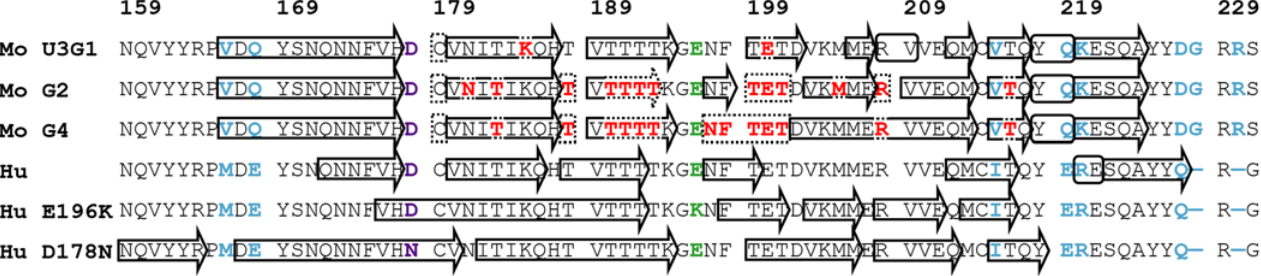
Figure 3. Comparison of secondary structures between mouse (Mo) and human (Hu) prion protein fibrils. The secondary structures of MoPrP(89 ‐ 230) U3G1, G2 and G4 condition fibrils were derived from secondary chemical shift analysis (see Supplementary Figure S5). Beta sheets are indicated with an arrow and residues with helical torsion angles are encircled with a rounded rectangle. Residues for which the secondary structure could not be determined are indicated with dots. Residues with missing assignments are colored red, sequence discrepancies between HuPrP and MoPrP sequences are colored blue, E196K mutation is green, D178N mutation is purple.